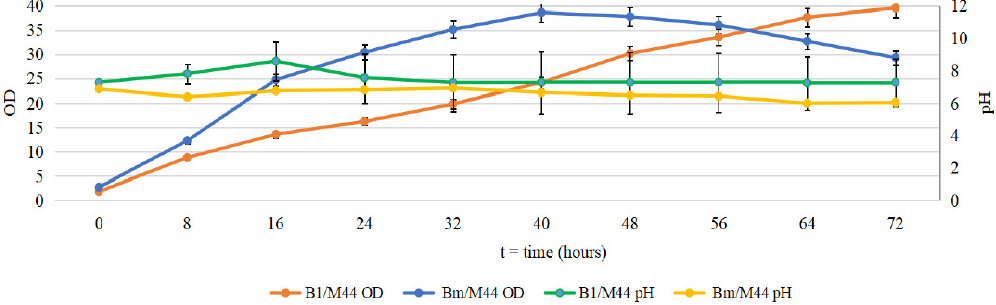
Figure 4. Growth of P. putida (B1) and B. mycoides (Bm) strains in M44 medium.